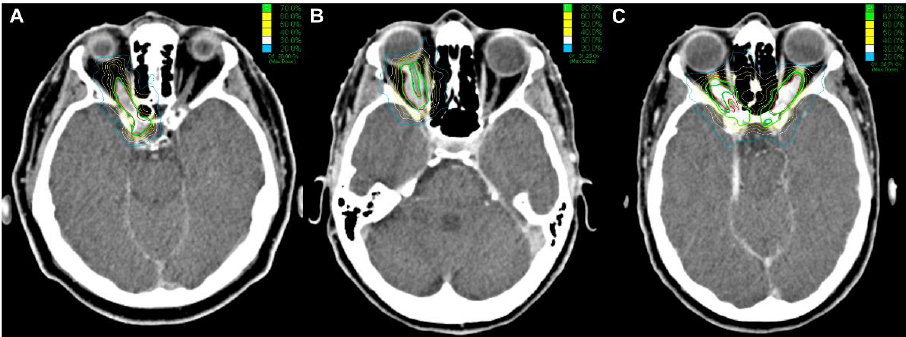
Figure 2. Cyberknife treatment planning showing axial planning-CT of a: ( A ) right sided ONSM without vision treated with 1 × 14 Gy (70% isodose); ( B ) right sided ONSM treated with 5 × 5 Gy (80% isodose) for vision preservation; ( C ) bilateral ONSM treated with 5 × 5 Gy (70% isodose) for the left and 5 × 4.5 Gy for the right side (red lines: PTV, green lines: prescription